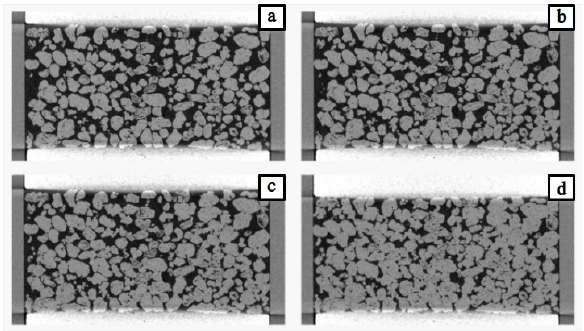
Figure 2. Vertical slices of the sample raw image data at t = 0h (a), t = 24h (b), t = 48h (c) and t = 96h (d). The sample is able to lift the deadload, but then collapses under it, while couscous grains continuously swell.